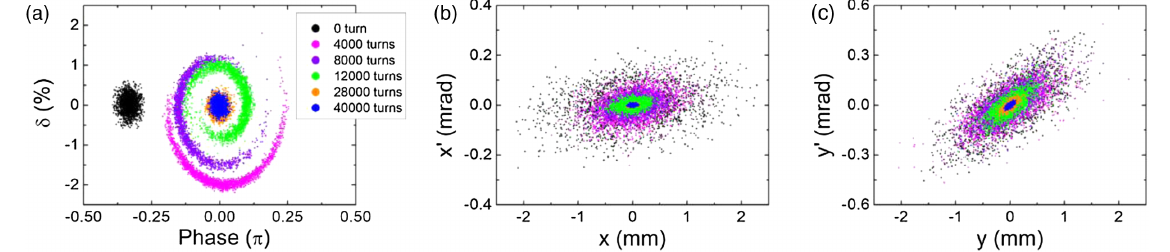
FIG. 6. Particle distributions in the longitudinal (a), horizontal (b), and vertical (c) planes with up to 40 000 turns following the injection.